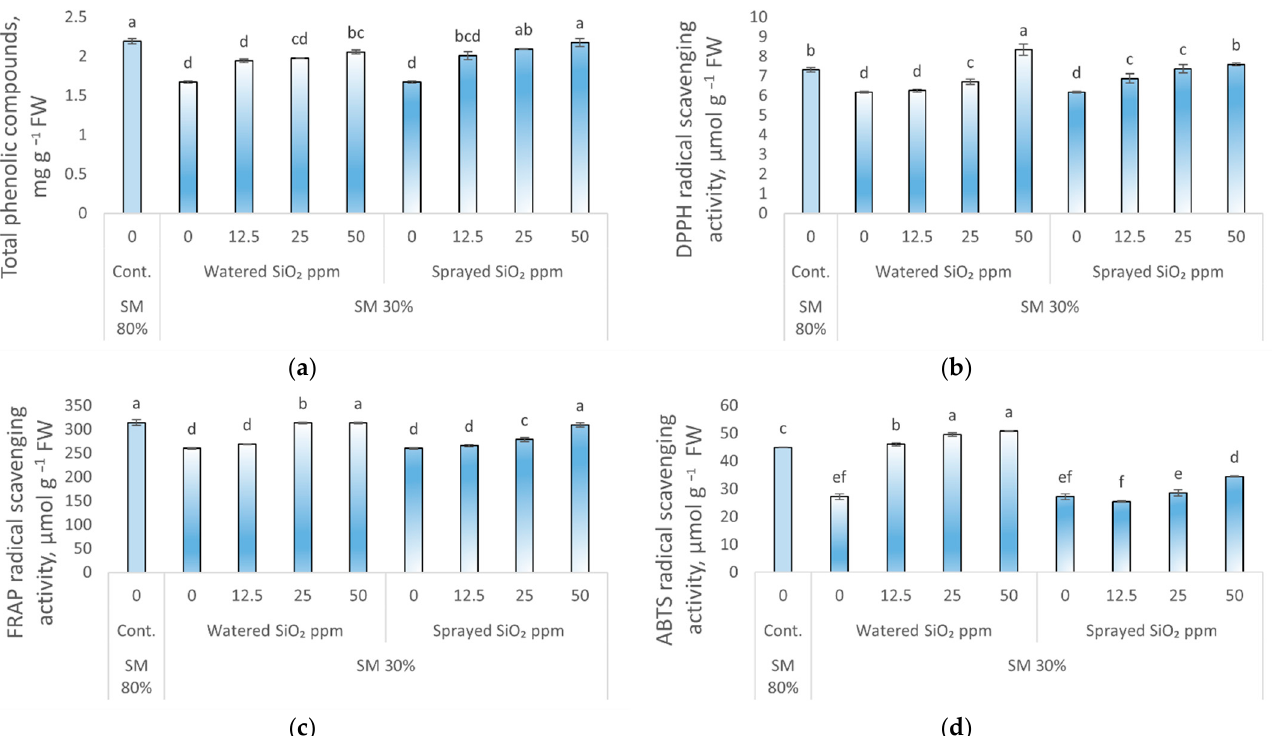
Figure 3. Influence of drought stress and SiO 2 NPs (0; 12.5; 25; and 50 ppm) on total phenolic compounds ( a ); DPPH radical scavenging activity ( b ); FRAP radical scavenging activity ( c ); ABTS radical scavenging activity ( d ) in P. sativum L. Cont.—control plants, substrate moisture (SM) 80%; drought stress—SM 30%. Values are mean ± SE of three replicates and different letters are differed significantly by Tukey HSD Test ( p < 0.001).